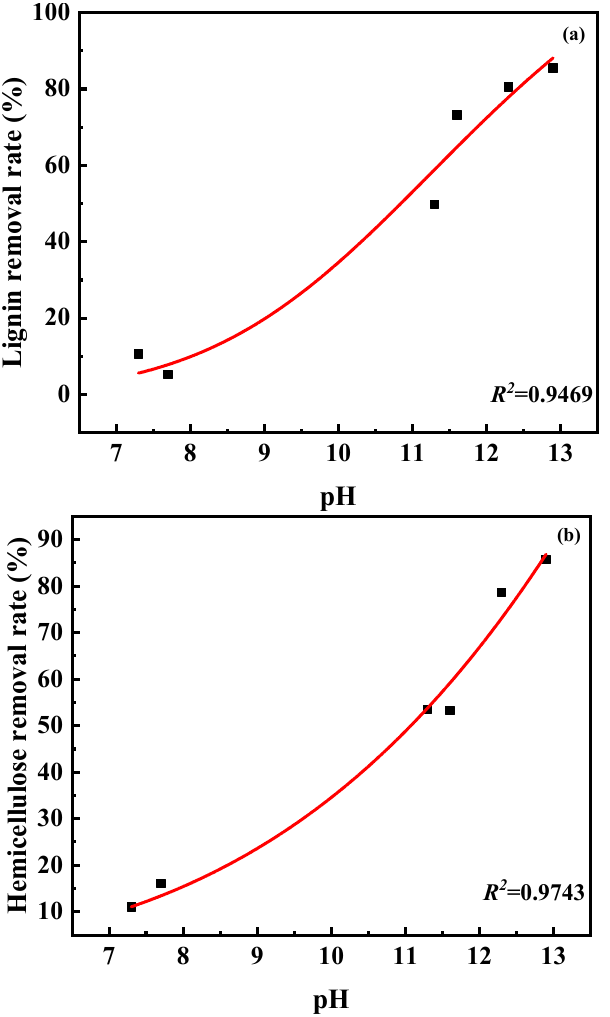
Figure 2. Correlation between pH value of DESs and lignin removal rate ( a ) and hemicellulose removal rate ( b ).